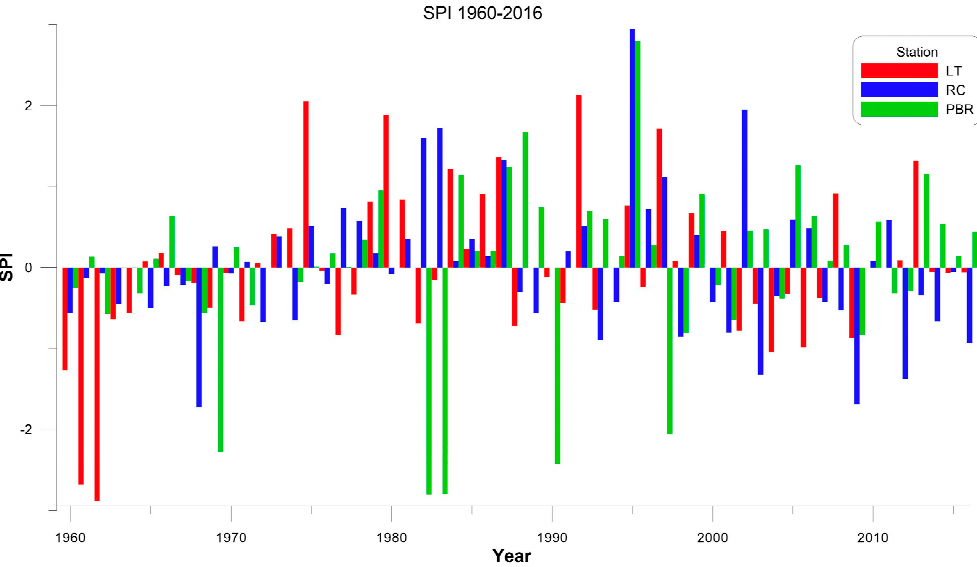
Figure 2. Standardized Precipitation Index (SPI) for the period of 1929 to 2016. SPI was calculated based on the annual precipitation data for 48 stations along the coast of Campeche.